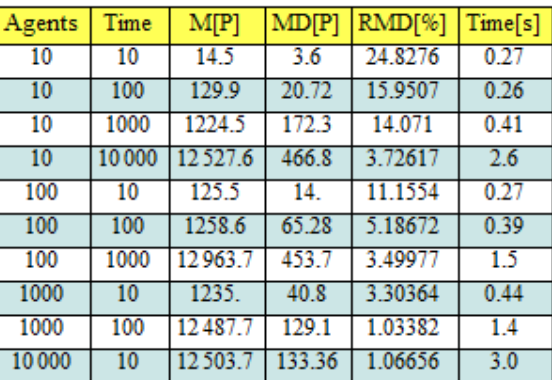
Figure 8. Rerunning the RWS algorithm with different parameter settings on Figure 5’s world 10 times. The vertical points represents from bottom: lower 95% confidence interval boundary; mean potential; upper 95% confidence interval boundary